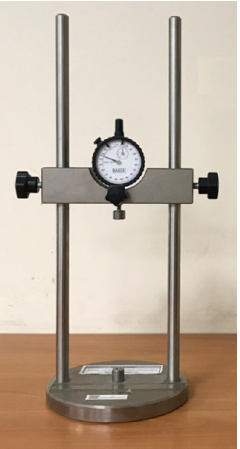
Figure 2. Device for determining the shrinkage deformation.